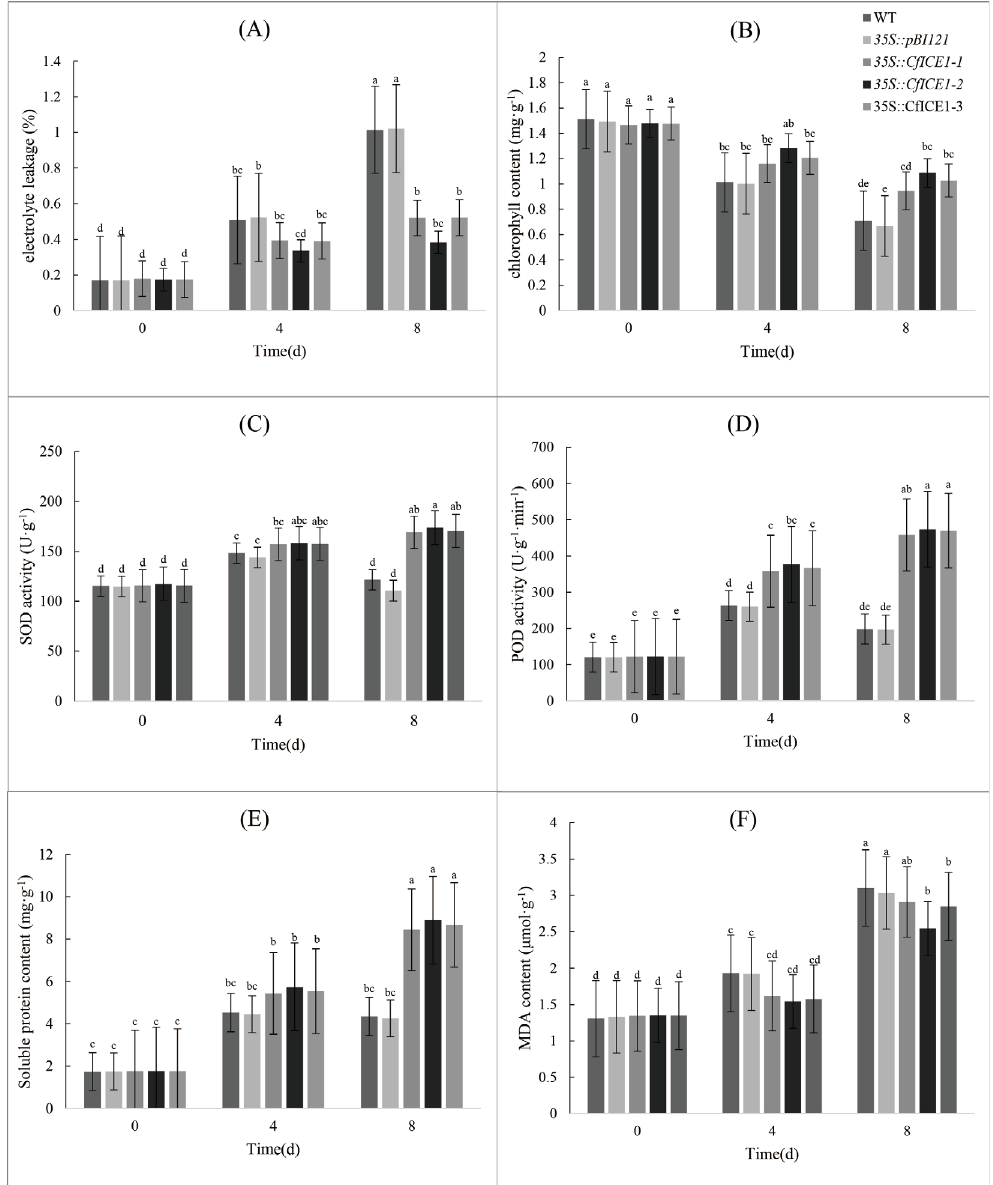
Figure 5. Physiological indices of transgenic, empty vector and wild-type poplar lines under salt stress: ( A ) electrolyte leakage, ( B ) chlorophyll content, ( C ) SOD activity, ( D ) POD activity, ( E ) soluble protein content, ( F ) MDA content. The abscissas of all the above physiological indicators are the days of salt treatment. Each bar indicates the average ± SD (n = 3), and lowercase letters above each bar indicate significant differences ( p ≤ 0.05).